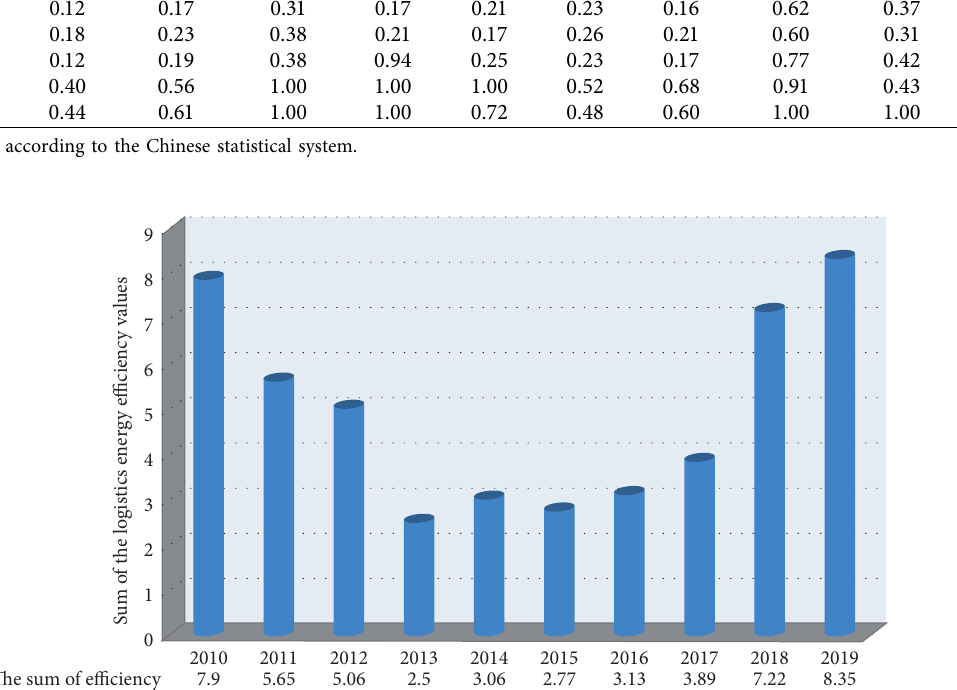
Figure 2: Sum of the logistics energy efficiency values of the 11 provinces and cities from 2010 to 2019.